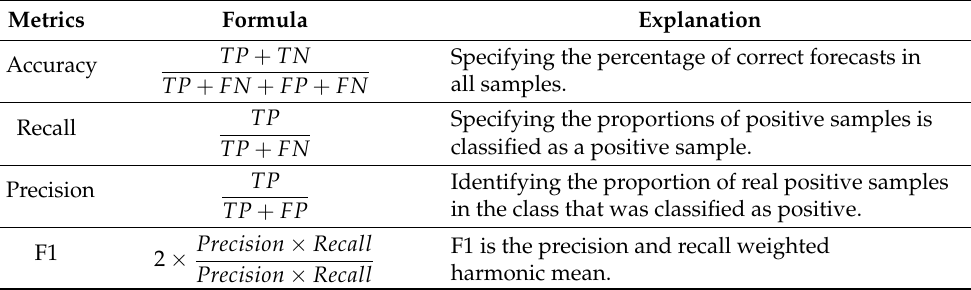
Table 7. Metrics for classification